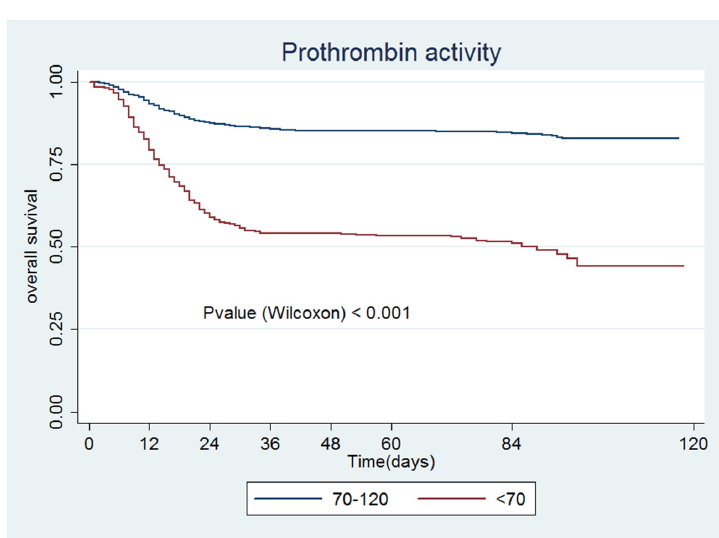
Figure 1. Prothrombin activity.